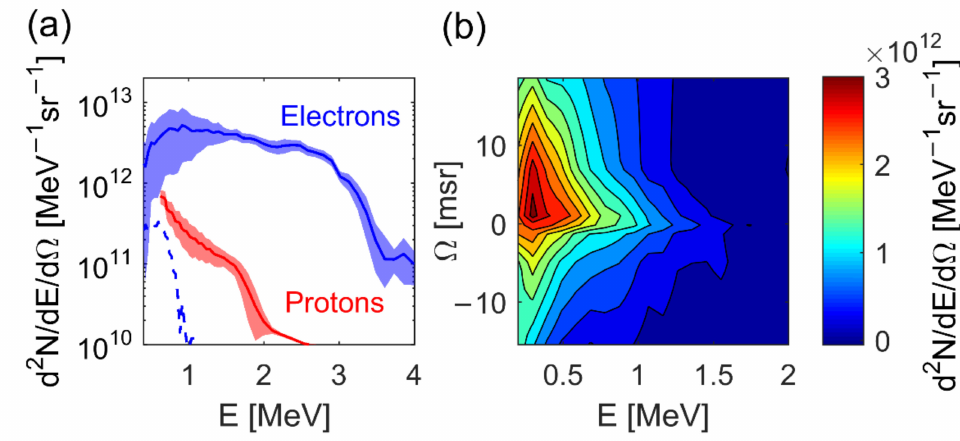
Figure 4. ( a ) Proton spectra from 14 consecutive shots without pre-pulse (red) and electron spectra from 11 consecutive shots with t = − 22 ns pre-pulses (blue). The shaded area represents the standard deviation between shots. The recorded electron spectrum of a shot without a pre-pulse is shown in dashed blue. ( b ) Charge spatial-spectral distribution of the electron